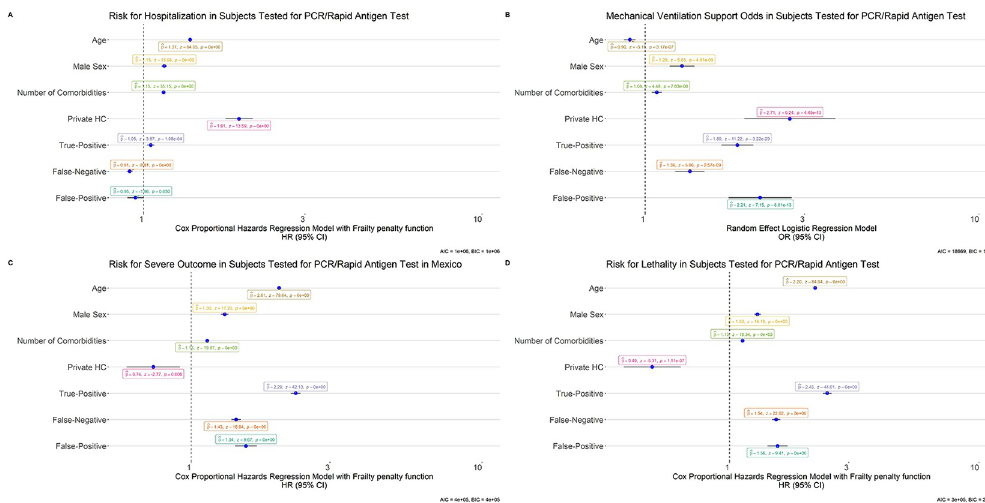
Fig 3. Models assessing risk associated to confusion matrix categories in rapid antigen test results compared to qRT-PCR for COVID-19 outcomes including hospitalization (A), requirement for intubation (B), risk of adverse outcomes (C) and lethality (D). Abbreviations: qRT-PCR: Reverse transcription polymerase chain reaction; CKD, Chronic Kidney Disease; CVD: cardiovascular disease; COPD: Chronic Obstructive Pulmonary Disease; OR: Odds Ratio; HR: Hazard ratio; 95%CI: 95% Confidence interval; HC: